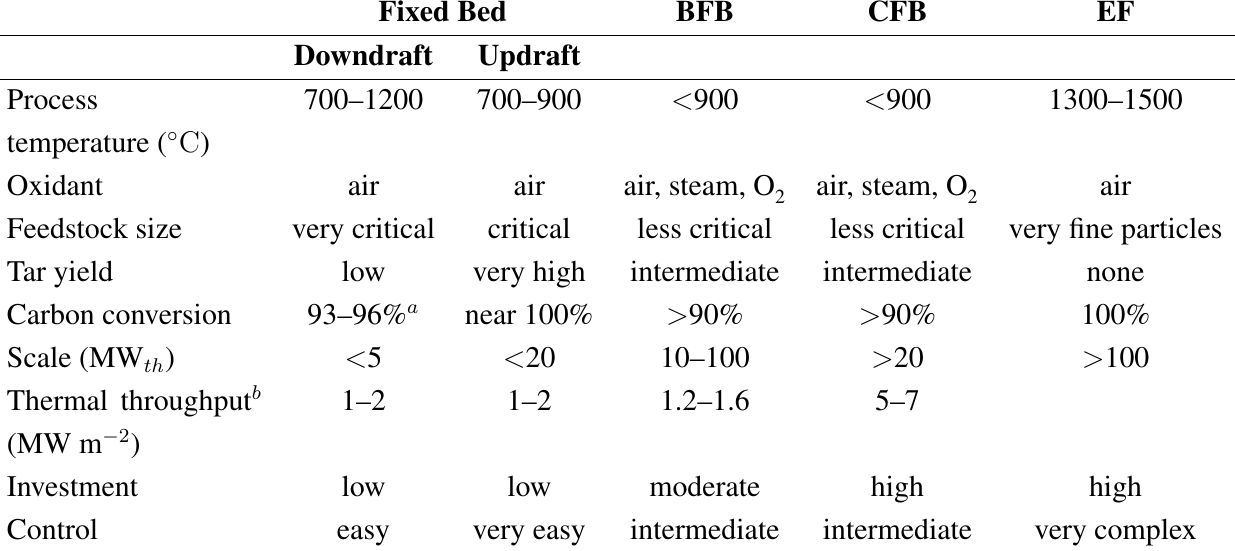
Table 5 . Main characteristics of the five established gasification reactor types (adapted from [69]).